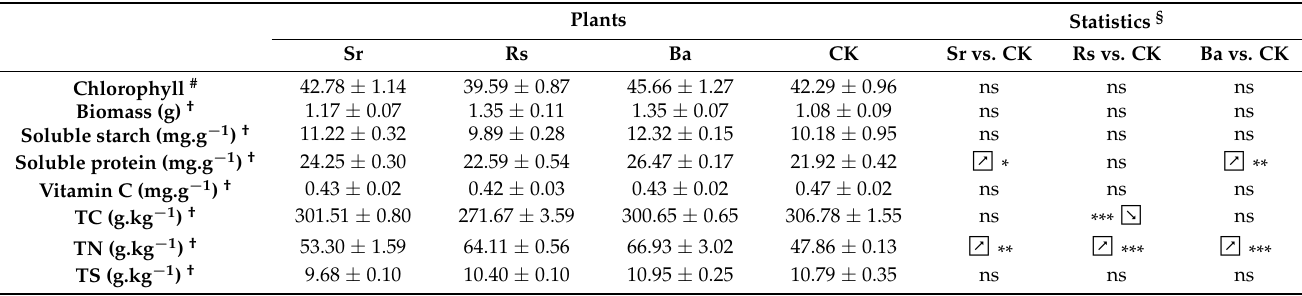
# Values are mean ± SE; n = 30. † Values are mean ± SE; n = 3. § HSD test. Significant levels: ns: p > 0.05; * p < 0.05; ** p < 0.01; *** p < 0.001. ↗ represents increase, ↘ represents decrease. Sr treatment significantly increased the concentrations of Al (5.45%), K (10.00%), P (24.37%), NH 4+ (473.70%), and NO 3 − (62.77%) in rhizosphere soil, as compared to the bulk soil (Table 3). Rs treatment significantly increased the concentrations of K (7.08%), NH 4+ (250.95%), and TC (28.17%) in rhizosphere soil compared with bulk soil (Table 3). Ba treat- ment significantly increased NH 4+ (142.64%) content but decreased the concentrations of Ca (14.06%), Mg (34.20%), Fe (14.11%), Mn (12.08%), Al (4.72%), and NO 3 − (38.21%). The content of TS in rhizosphere soil significantly decreased compared with bulk soil in all PGPR treatments. There was no statistical difference between rhizosphere and bulk soil of the CK treatment, except for the increase of NH 4+ (476.96%) content.